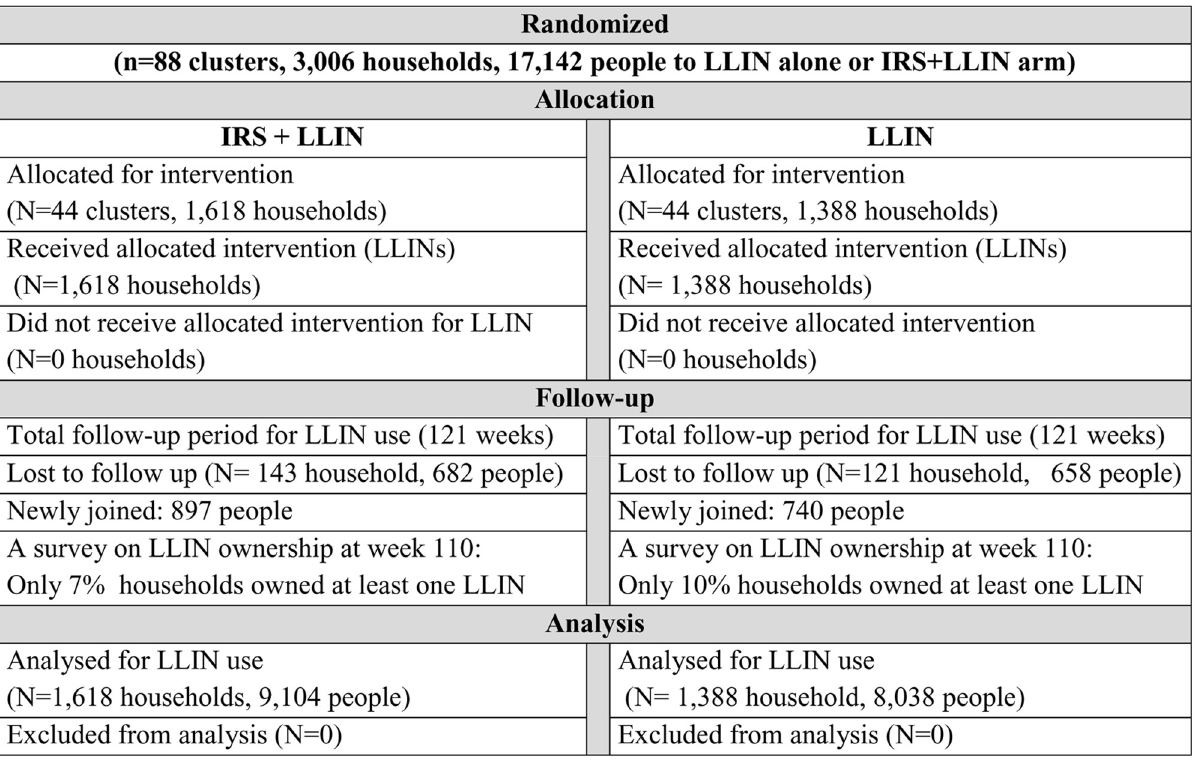
Fig 2. Flow chart of the study for weekly long-lasting insecticidal nets use in Adami Tullu District south-central Ethiopia, October 2014 to January 2017.